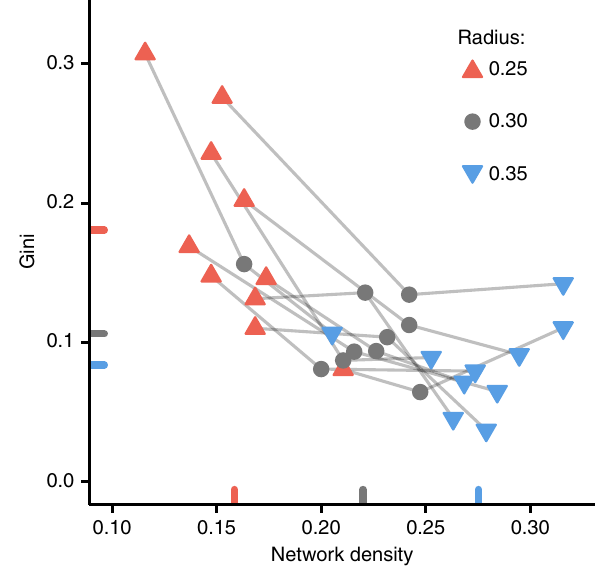
Fig. 3 Wider connection range decreases economic inequality, but the change is diminishing. Dots indicate network density and fi nal Gini coef fi cient for each session ( N = 30 sessions). Light gray lines bind sessions having the same geometric con fi guration (i.e., location of the nodes on the plane) set with different connection ranges (e.g., the networks of Fig. 2) shown as dot color and shape. Average network density and Gini coef fi cient across the connection radii are shown as colored ticks on X - and Y -axis Radius 0.25